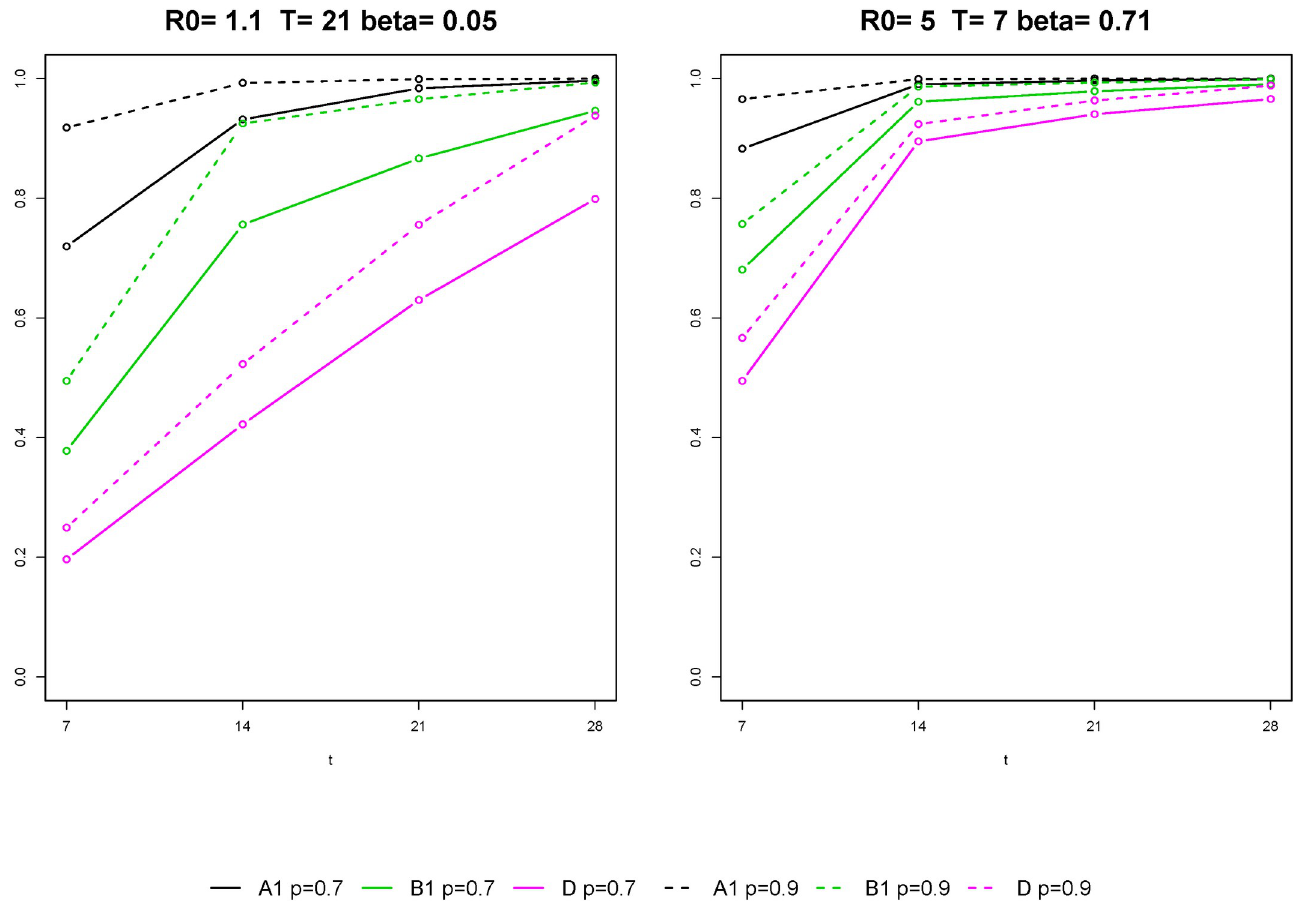
Fig 4. Probability of detecting the infection within t days ( t = 7, 14, 21, 28) from the beginning of the epidemic in the class. Comparison of the performance of the screening plans A1, B1, D, under the scenarios characterized by the lower (left panel) and the largest (right panel) rates of contagion, assuming that individual tests have sensitivity 0.7 (solid line) and 0.9 (dashed line) and maximum specificity.